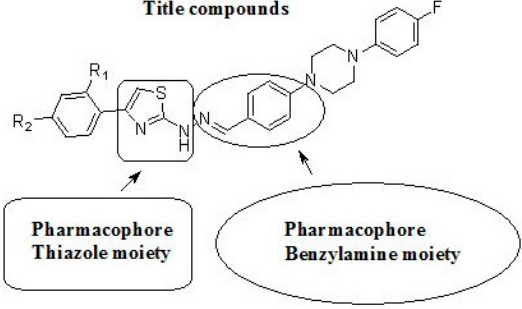
Figure 3. General structure of target compounds.